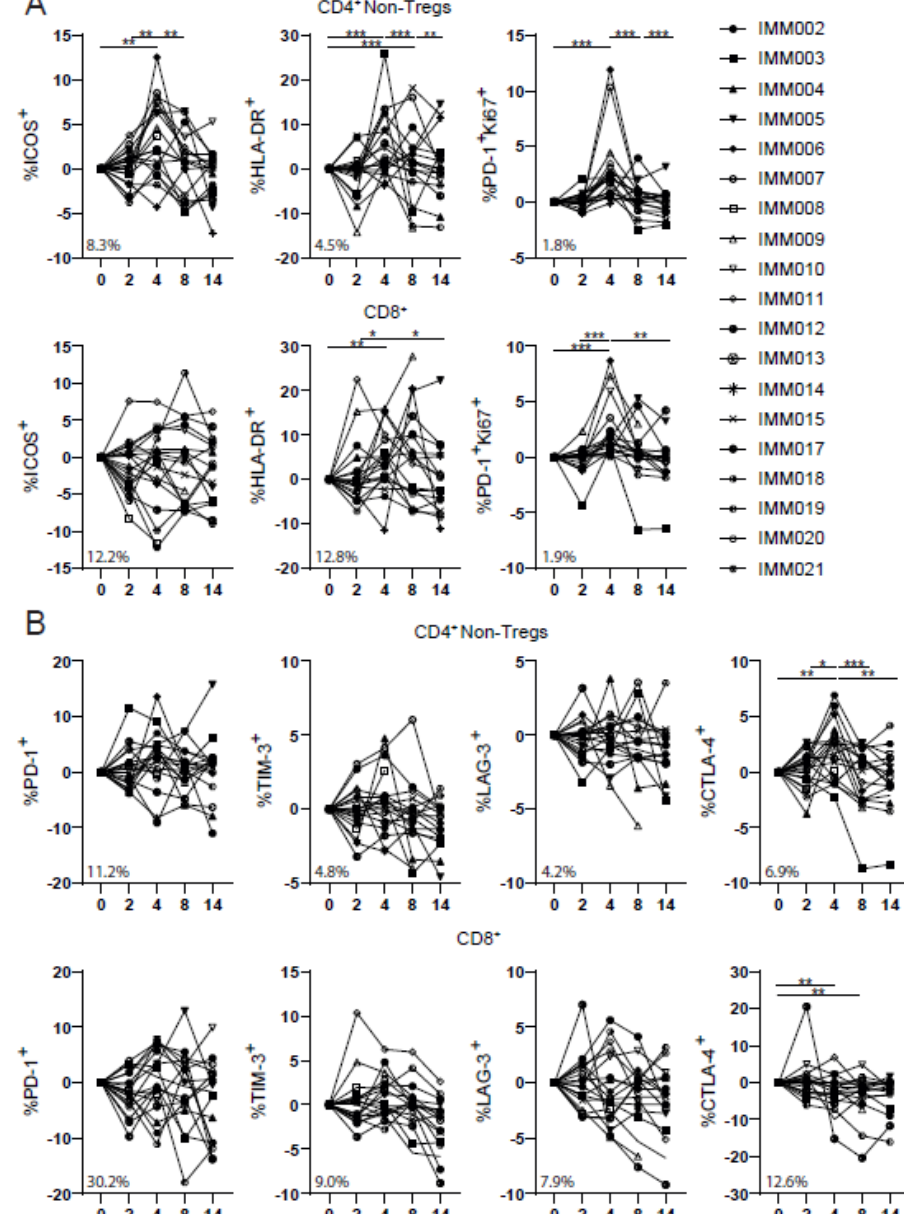
Figure 4. SBRT/IMM-101 induced T-cell activation. ( A ) Percentage of ICOS+, HLA-DR+, PD- 1+/Ki67+ subsets of CD4+ Non-Tregs and CD8+ cells. ( B ) Percentage of PD-1+, TIM-3+, LAG-3, CTLA-4+ subsets of CD4+ Non-Tregs and CD8+ cells. N = 19. Data were normalized for baseline (week 0) and paired per patient. Percentage in the bottom left corner is the average frequency at baseline. Significance was determined using the paired Wilcoxon signed-rank test. * p < 0.05, ** p < 0.01, *** p < 0.0001.